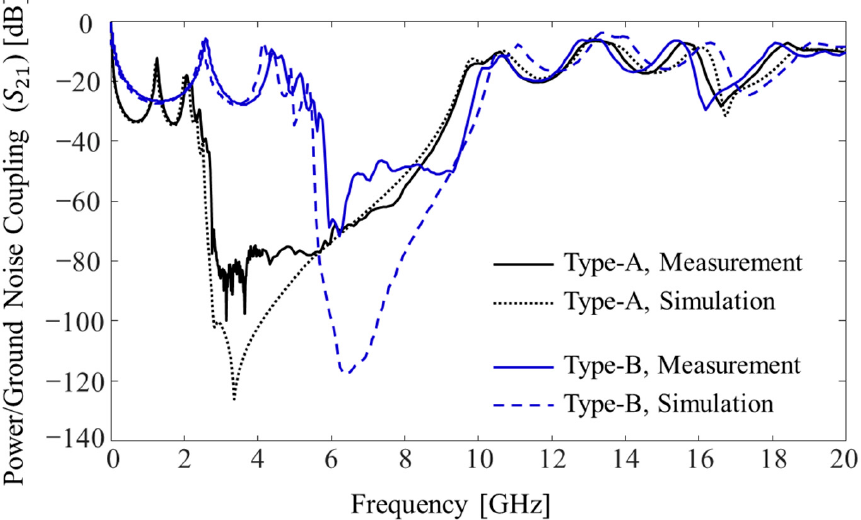
Figure 9. Measured power/ground noise couplings are compared with simulated results. Table 3. Summary and comparison of measured, simulated, and estimated stopband edges. Structures